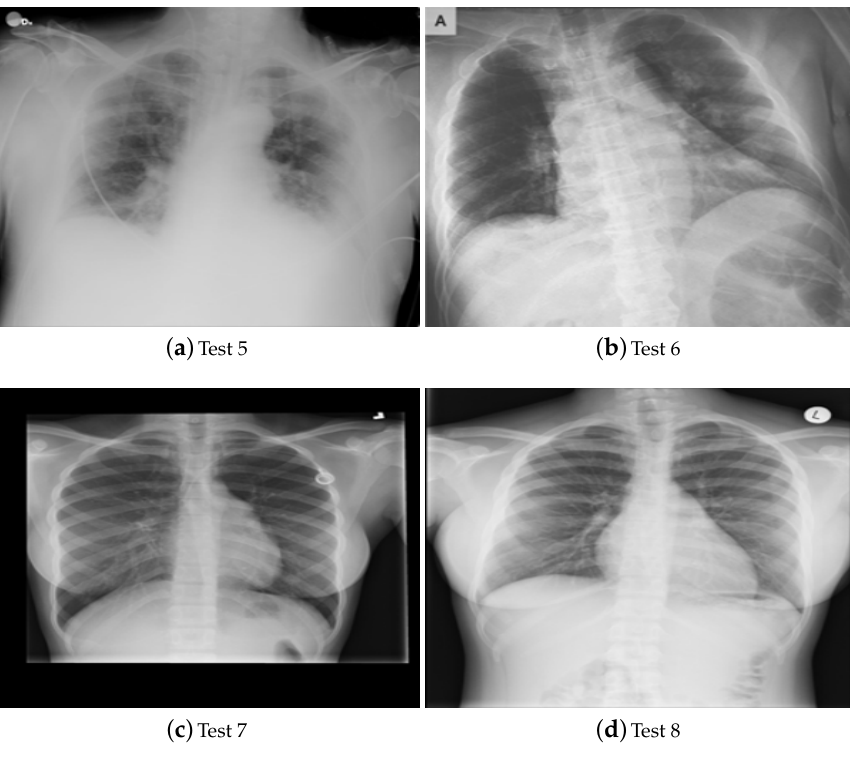
Figure 5. The CT benchmark images that were